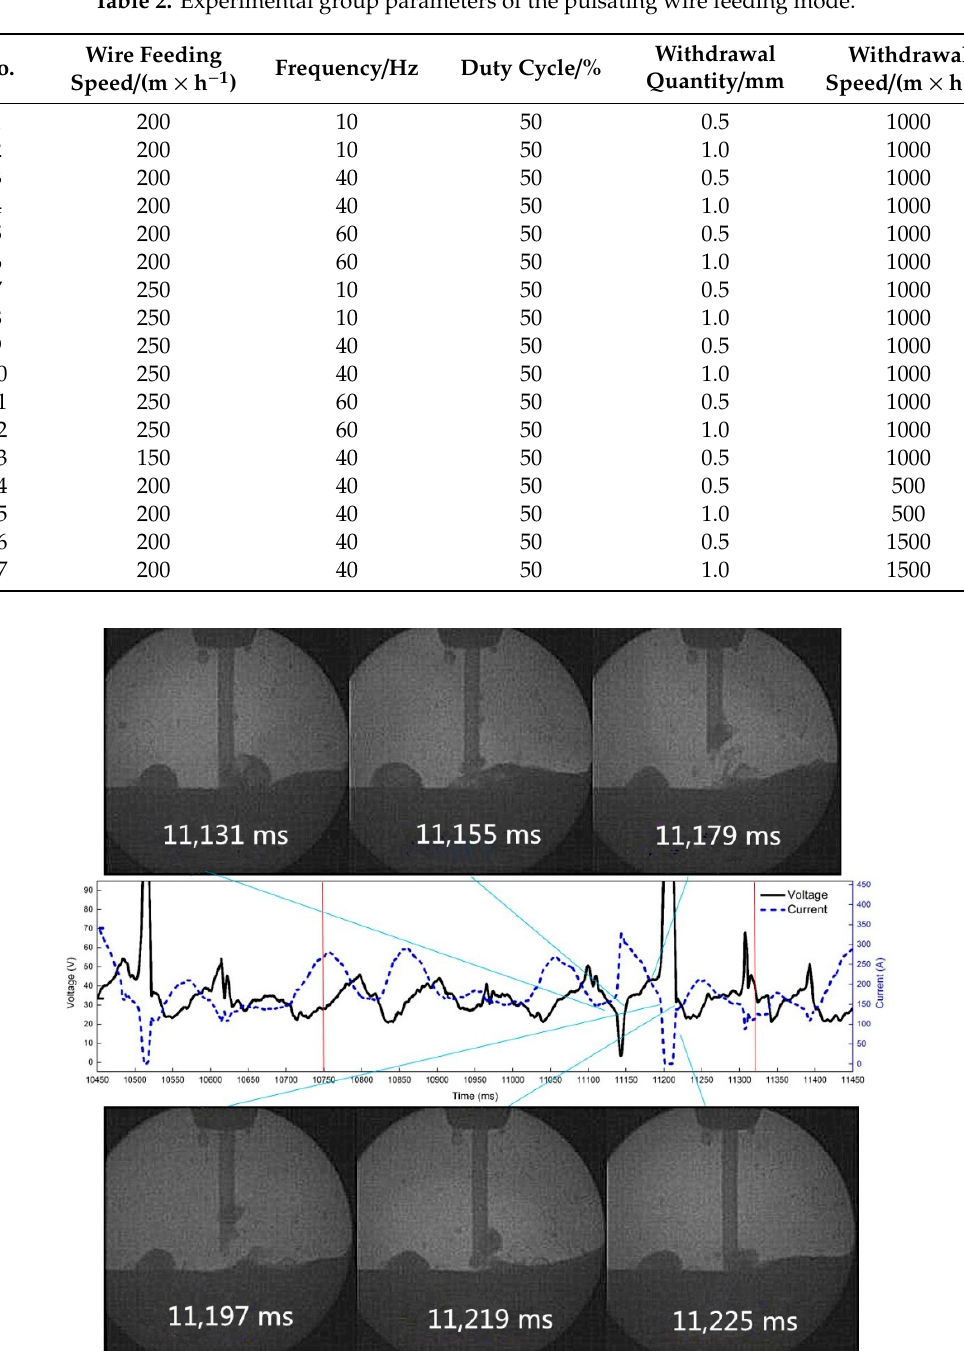
Figure 3. Droplet transition process at 10 Hz and 0.5 mm withdrawal quantity.